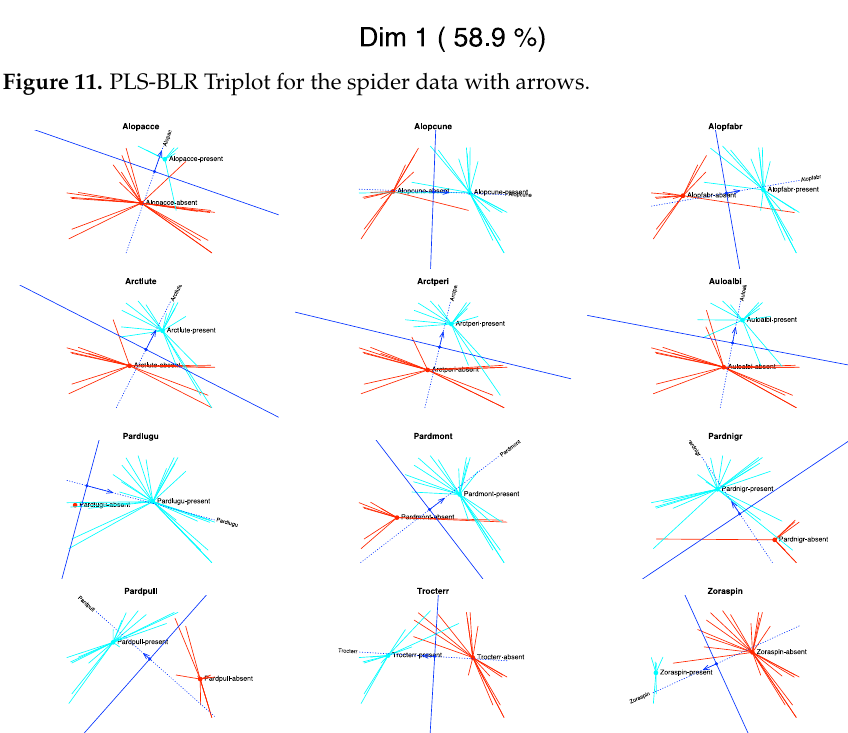
Figure 12. Prediction regions for each